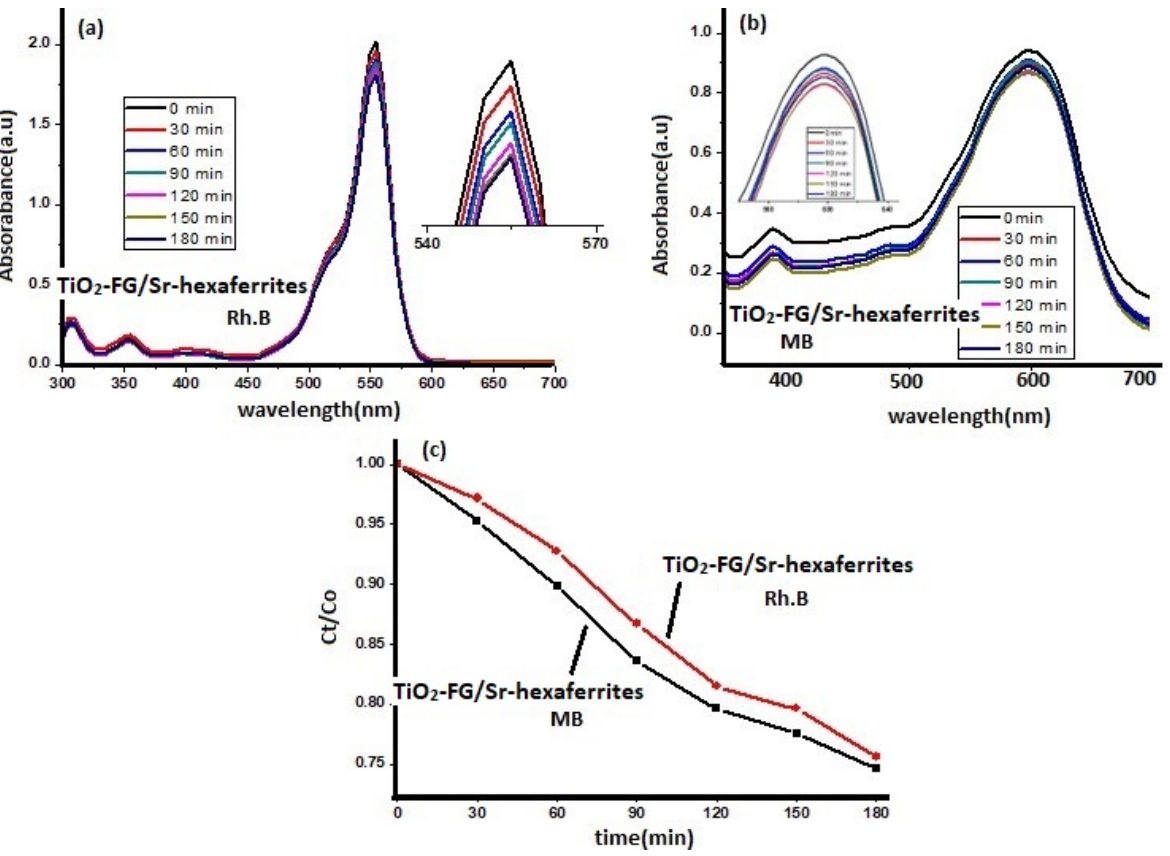
Figure 8. UV ‐ vis spectra. ( a ) Rh. B degradation by TiO 2 ‐ FG/Sr ‐ hexaferrites; ( b ) MB degradation by Figure 8. UV-vis spectra. ( a ) Rh. B degradation by TiO 2 -FG/Sr-hexaferrites; ( b ) MB degradation by TiO 2 -/FG/Sr-hexaferrites; ( c ) concentration plot of TiO 2 -FG/Sr-hexaferrites. TiO 2 ‐ /FG/Sr ‐ hexaferrites; ( c ) concentration plot of TiO 2 ‐ FG/Sr ‐ hexaferrites. To achieve adsorption and desorption equilibrium, the catalytic chamber was left in the dark for two hours. The chamber was then exposed to vis-light for 30 min after adsorption–desorption equilibrium was reached. The sample was collected for